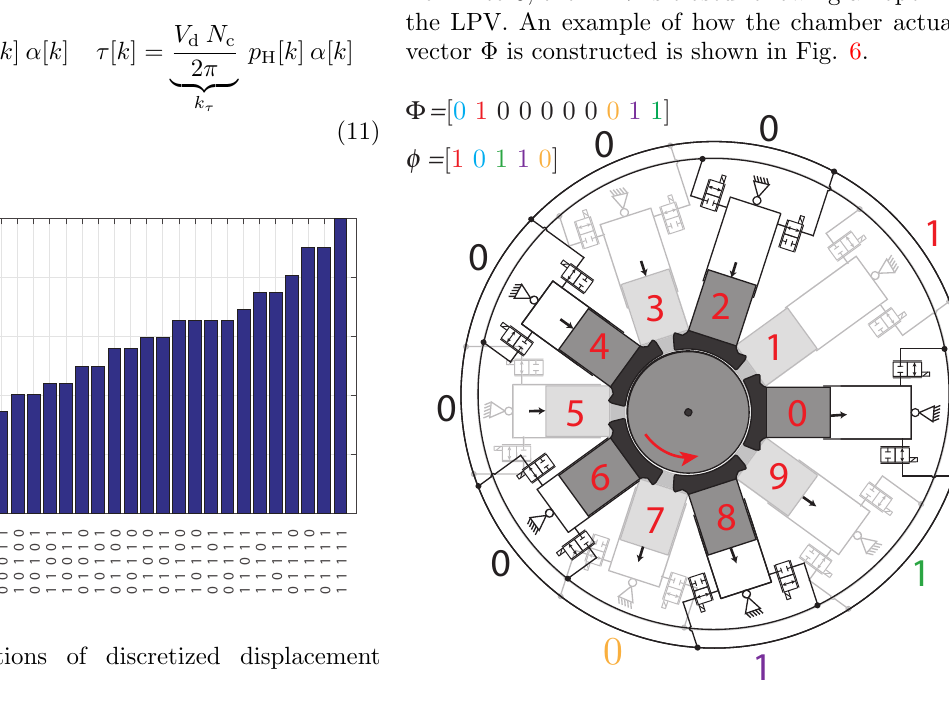
Figure 6: Example of the chamber actuation sequence